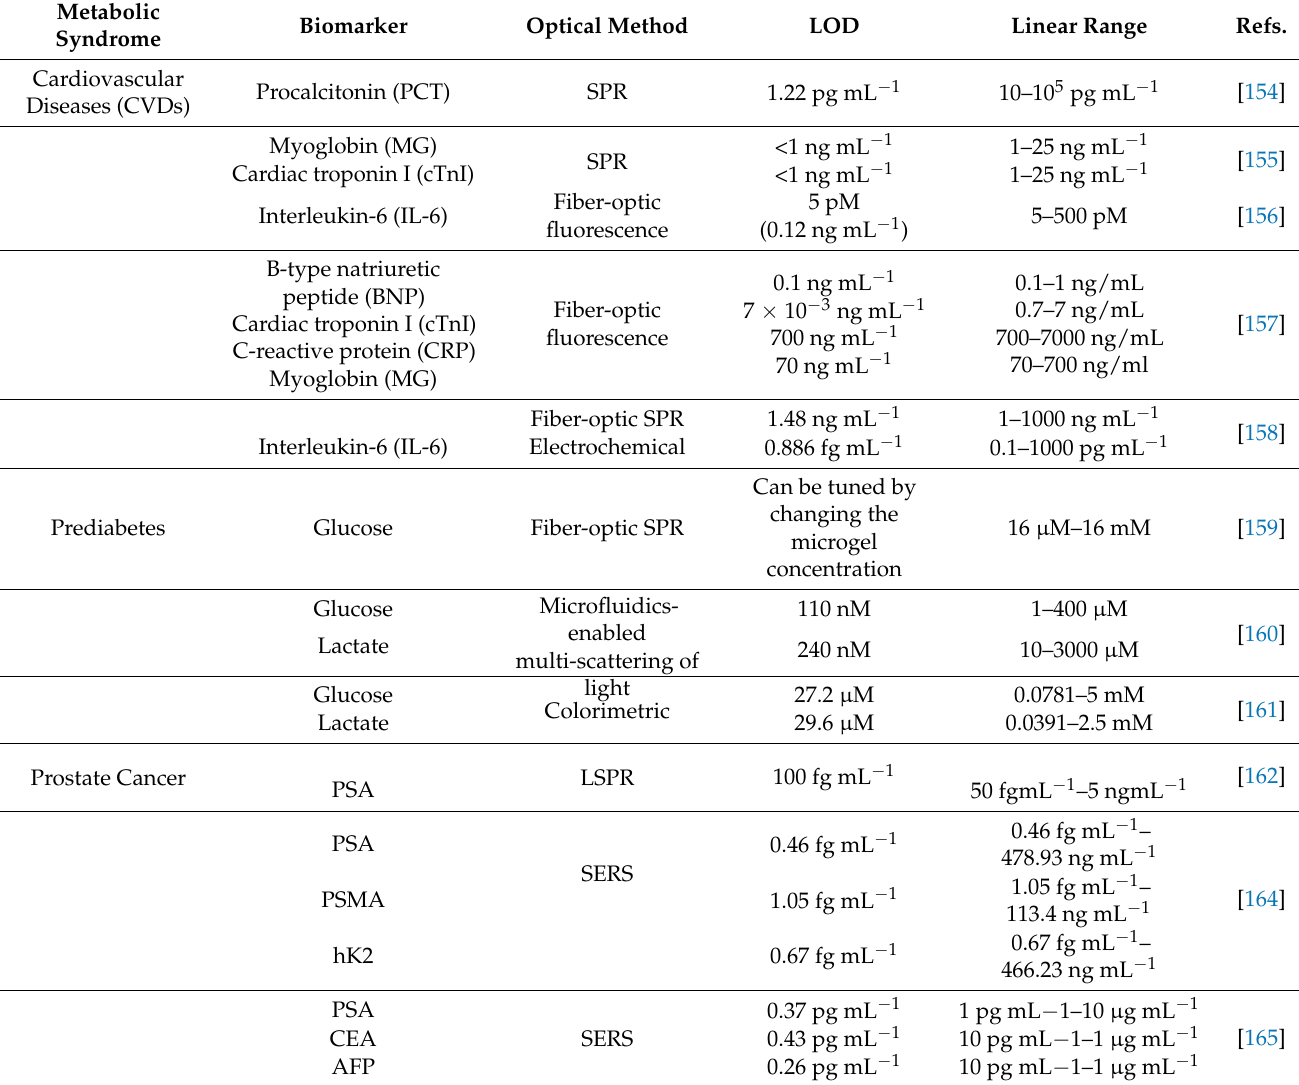
Table 3. Optical sensors for multiplexed detection of biomarkers for metabolic syndrome (MS). Optical Method LOD Linear Range